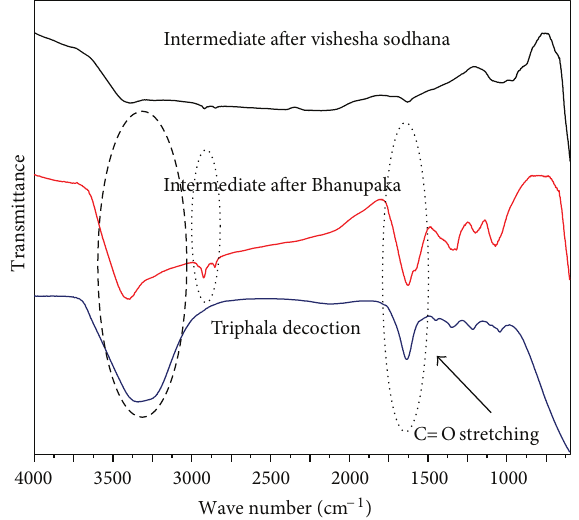
Figure 6: FTIR spectra of intermediate after vishesha sodhana and the intermediate after Bhanupaka